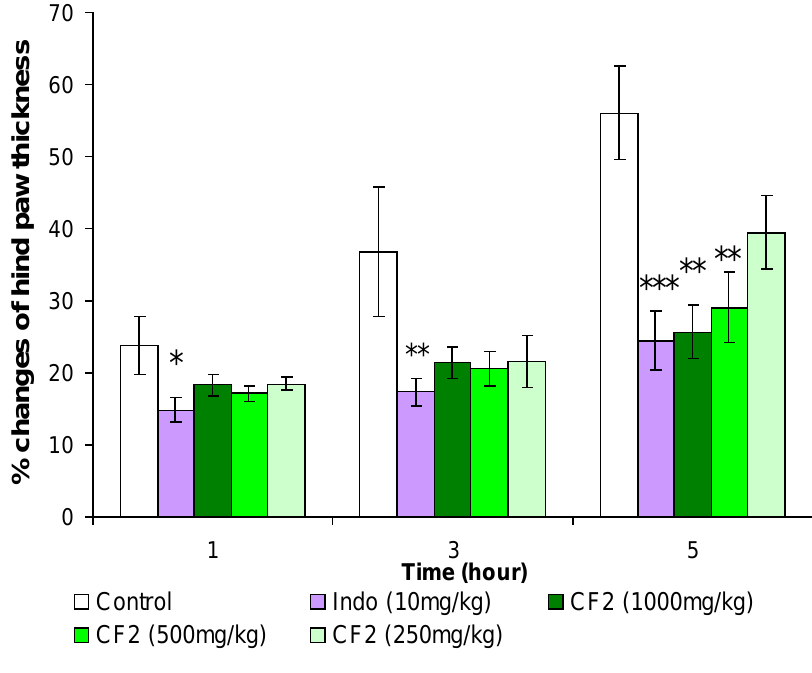
Figure 2. Effects of various doses of chloroform extract fraction 2 of Orthosiphon stamineus leaf on carrageenan-induced rat hind paw edema (n = 6).